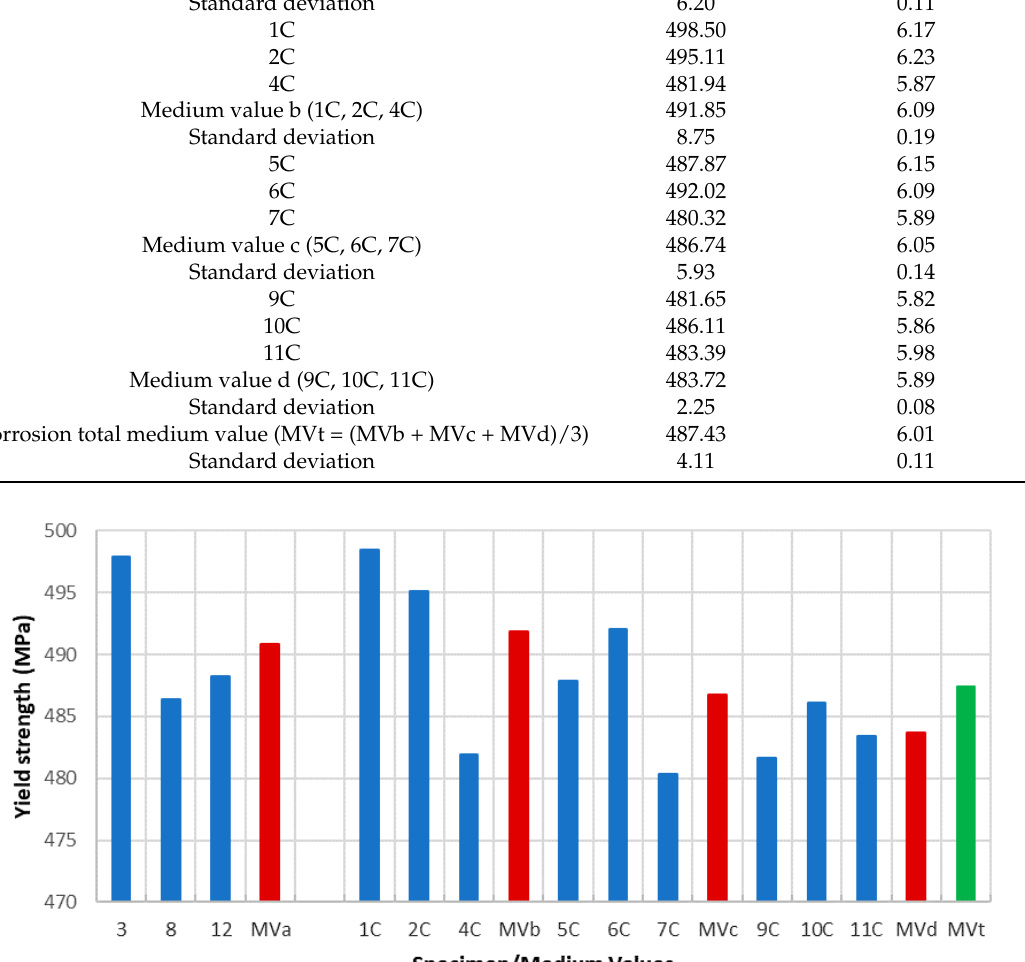
Table 4. Yield strength and yield strength/section relation values per specimen and Medium values.